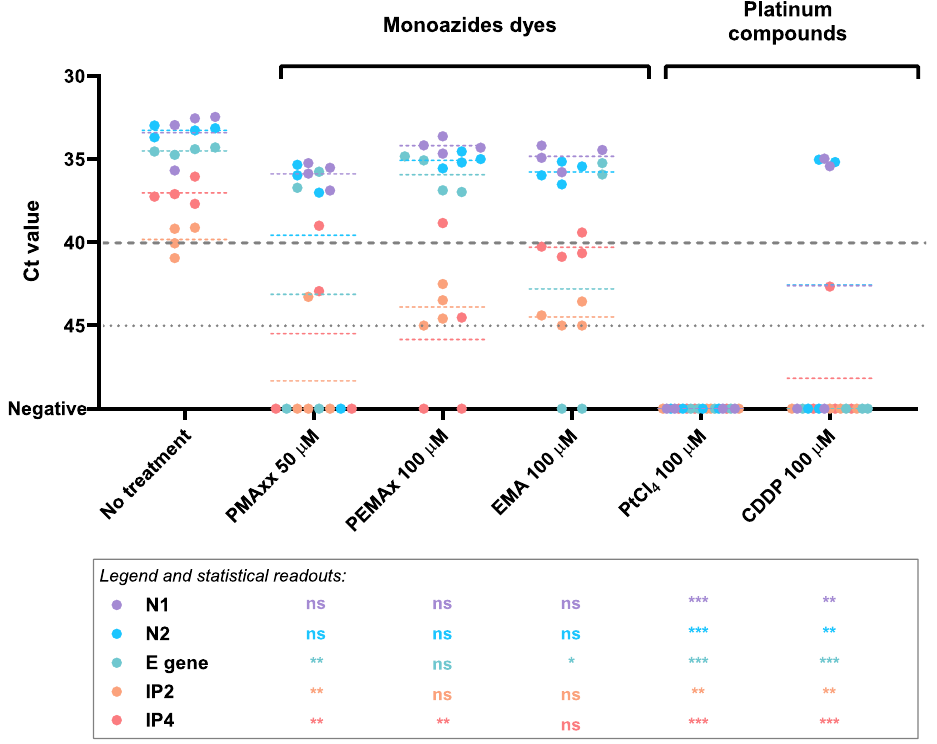
Figure 1. Performance of monoazide photoactivatable dyes and platinum compounds on SARS-CoV-2 genomic RNA assessed by targeting five different RNA regions. Dashed grey line represents RT-qPCR theoretical limit of detection for N1, N2 and gen E; dotted grey line represents RT-qPCR theoretical limit of detection for IP2 and IP4. Asterisks indicate significant difference from untreated control for each